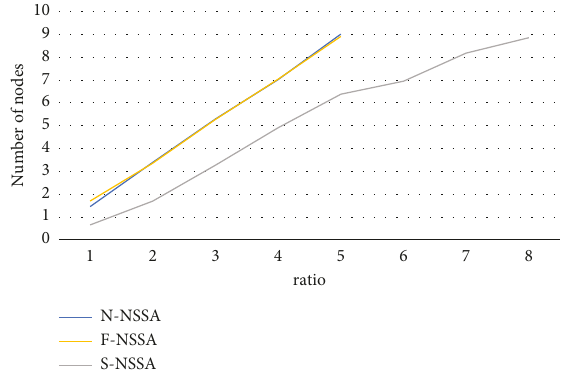
Figure 10: Acceleration ratio of different